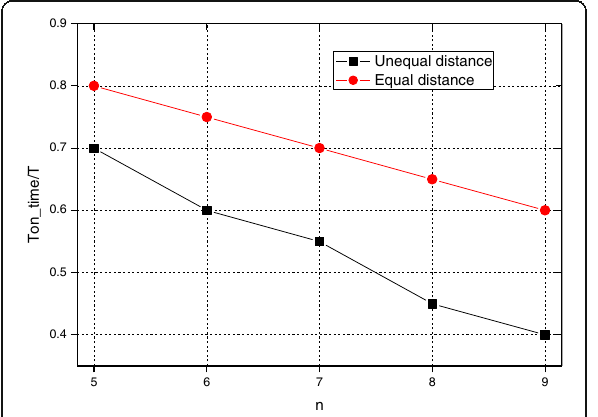
Fig. 35 The optimal duty cycle under UDNP and EDNP (MPSK)